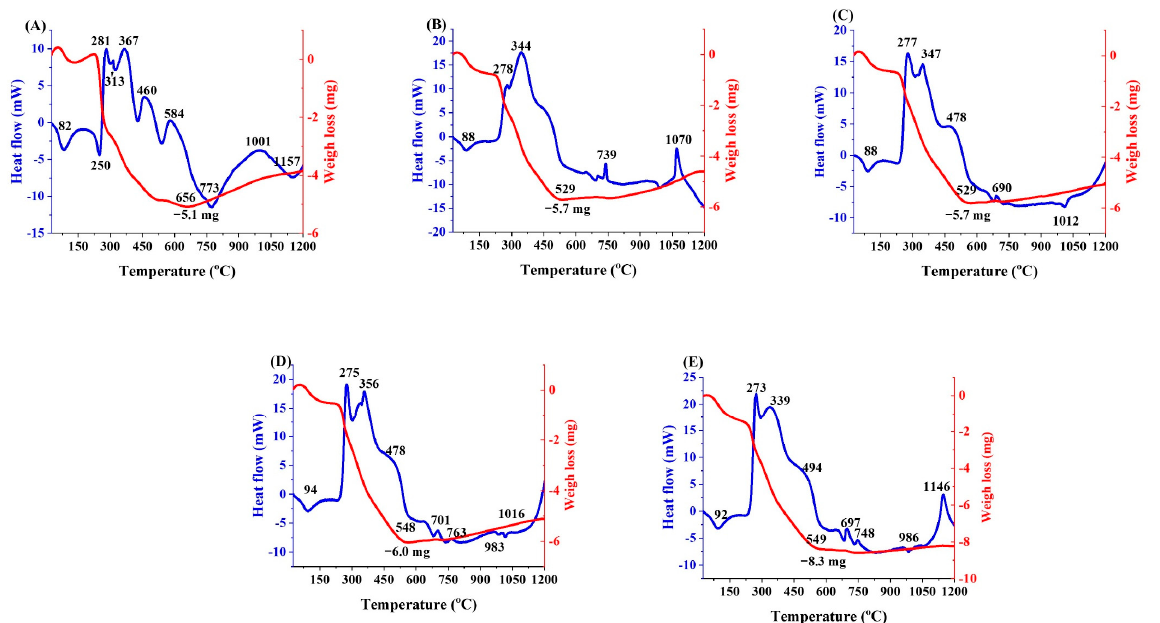
Figure 2. ( A – E ): DTA/TGA graphs of the Ag-free ( A ) and the Ag-doped (1, 2.5, 5, 7.5 mol%) MBGs ( B – E ).